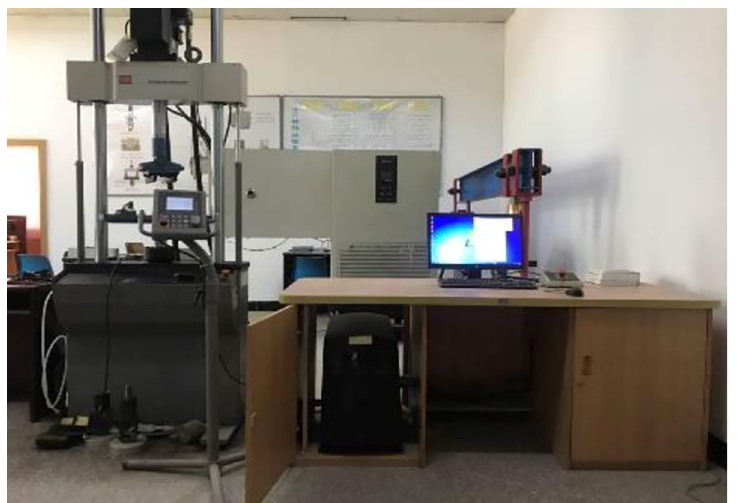
Fig 1. MTS-810 material testing machine.